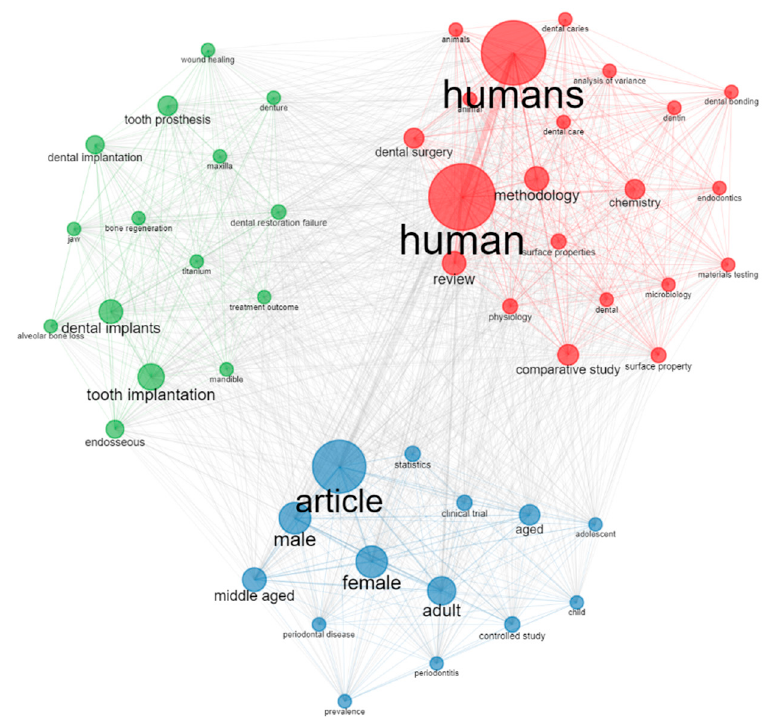
Figure A1. Conceptual Structure. World Dentistry Co-occurrence Network (1996–2020) generated with Bibliometrix [30]. Sort on: Cited by (highest) first 2000 document results retrieved. Field: Key- word Plus, Network Parameters: Network Layout (Automatic layout), Normalization (Association), Number of nodes (50), Clustering Algorithm (Louvain), Node Color by Year (No), Repulsion Force (0,1), Minimum number of edges (2), Remove isolated nodes (Yes). Graphical parameters: Opacity (0,7), Label cex (Yes), Label Size (Yes), Node Shadow (No), Number of labels (50), Node Shape (Dot), Edge Size (5), and Curved edges (No). Scopus Search Query: SUBJAREA (dent) AND